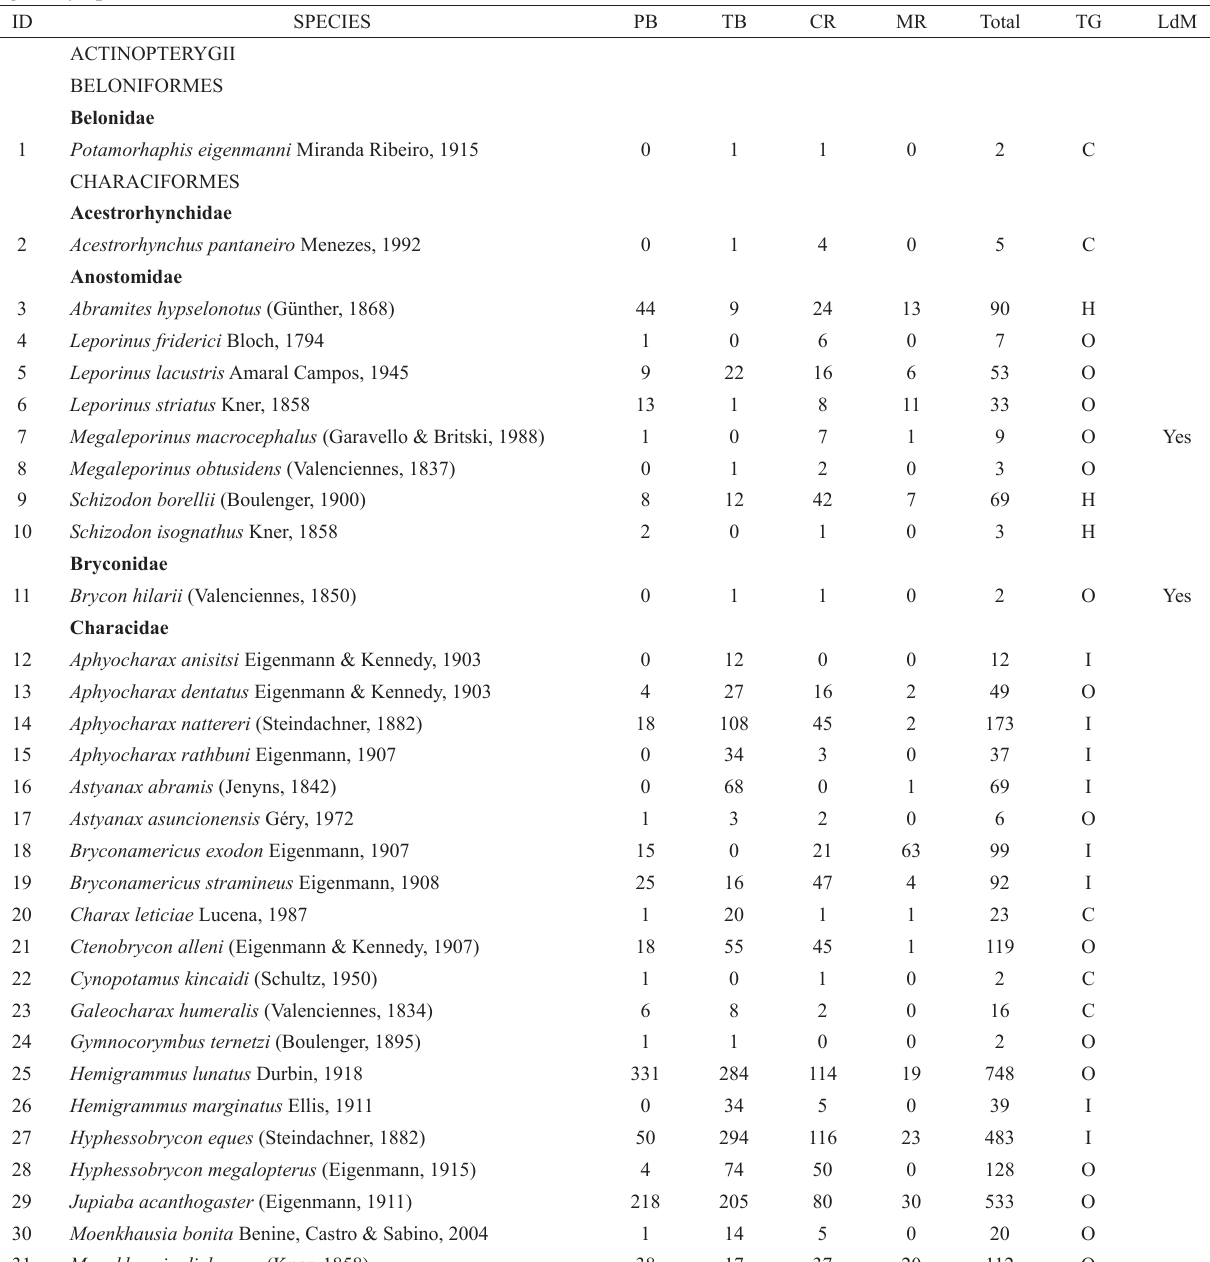
Tab. 2. Taxonomic list of sampled species according to Eschmeyer, Fricke (2017) and species abundance, feeding and migratory guilds in the region sampled in the Pantanal National Park, during the dry season (Oct-Nov, 2010 and 2011). PB - permanent bays, TB - temporary bays, CR - “corixos”, MR - main rivers. TG - trophic guilds; C - carnivores; I - insectivores/ invertivores; O - omnivores; D - detritivores; H - herbivores; ND - not determined trophic guild; LdM - long-distance migratory